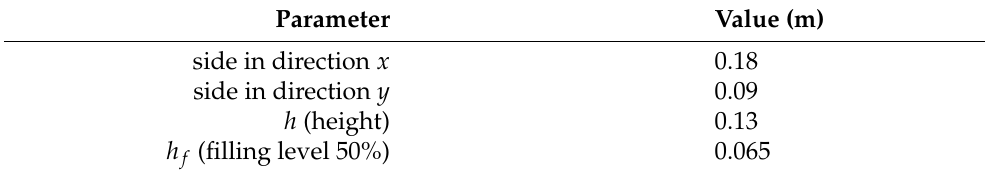
Figure 5. Configuration with two box-shaped tanks placed under the BFF wings. Table 3. Tank geometry—Case study 2.